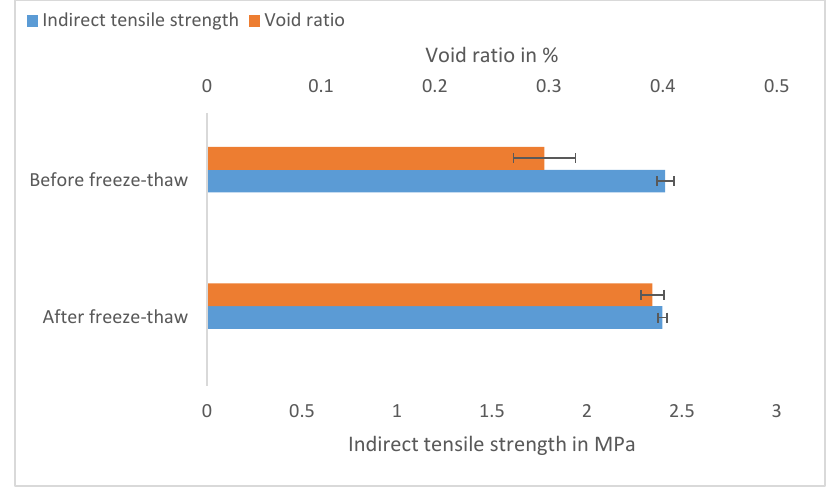
Figure 6. Indirect tensile strength and void ratio changes after freeze–thaw cycles.